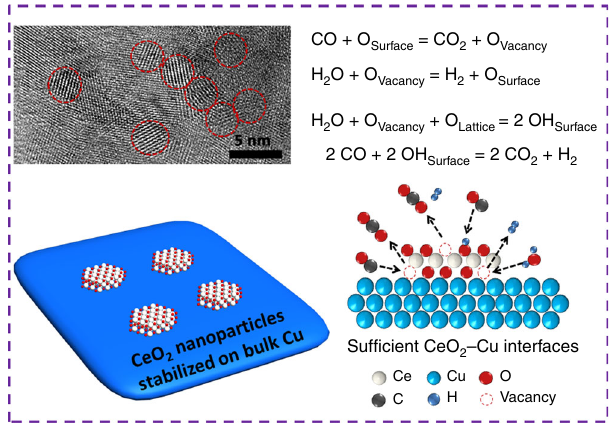
Fig. 6 Role of inverse CeO 2 /Cu in catalyzing the WGS reaction. Role of the CeO 2 – Cu interfaces in catalyzing the WGS reaction on inverse CeO 2 /Cu catalyst